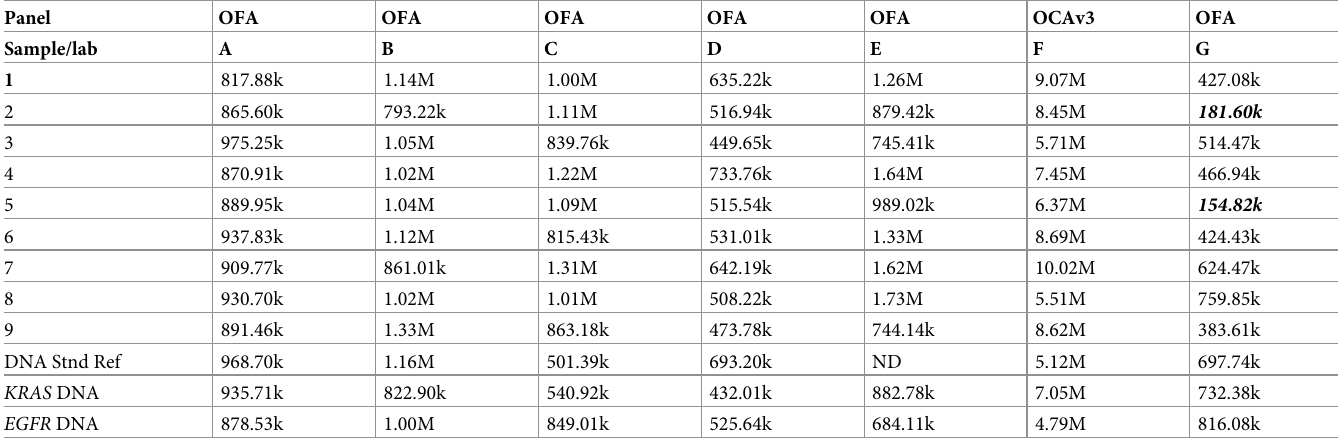
Table 3. Phase 1 DNA mapped read values.